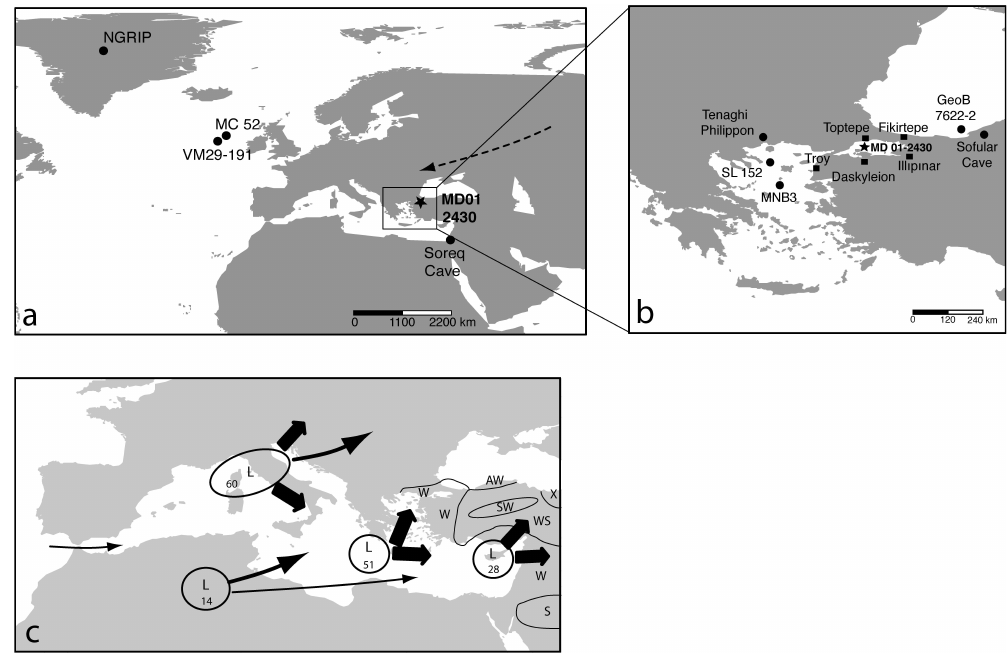
Fig. 1. Location of the sites discussed. (a) NGRIP ice core, North Atlantic (MC52 and VM29-191) and the Near East (speleothem from Soreq Cave). The dashed arrow indicates the western riding of the Siberian High during winter/spring (Marino et al., 2009). (b) Highlight of the sites located in Northeastern Mediterranean: sediment core in the Sea of Marmara (MD01-2430), marine cores in the Aegean Sea (SL152 and MNB3), marine core in the Black Sea (GeoB 7622-2), continental core in Greece (Tenaghi Philippon) and speleothem from Sofular Cave. Some archaeological sites are indicated by black squares. Map (c) indicates seasonal rainfall and the movement of depression within the Mediterranean (modify by Boucher, 1974). Seasons of maximum rainfall are shown only for Turkey and Near East: W (winter), A (autumn), S (spring) and X (indistinct). Figures in the lows indicate annual mean frequency of